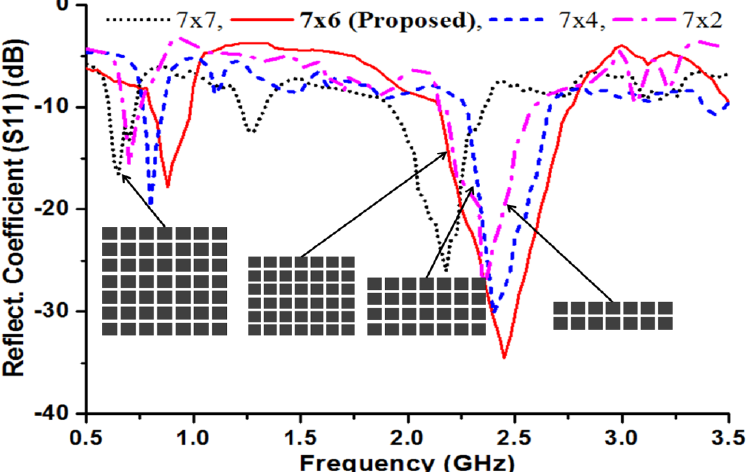
Figure 6. Effect of metasurface element sets over the reflection coefficient of the proposed